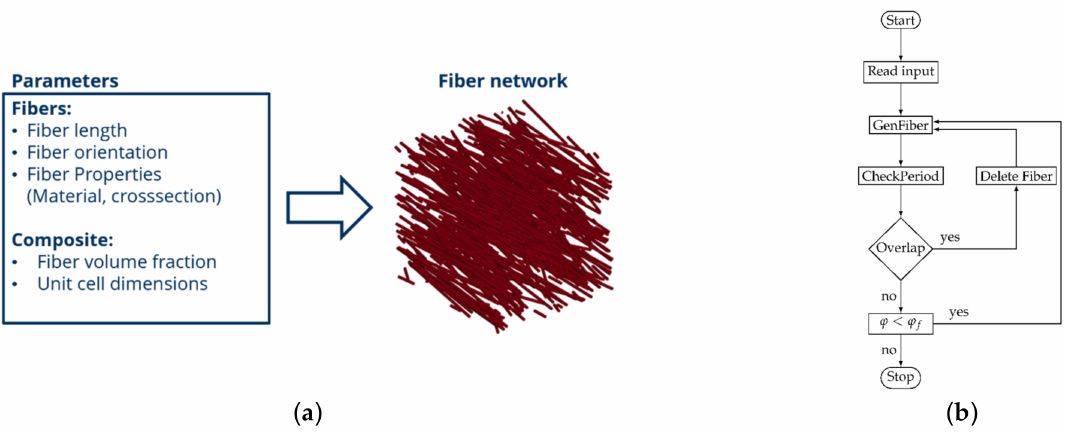
Figure 3. RVE model generation steps: ( a ) Modeling overview, ( b ) Process diagram.